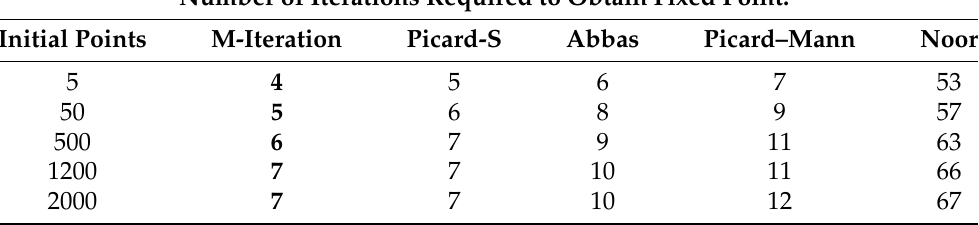
Figure 1. Convergence behaviors of different iterative schemes to a fixed point p 0 = 0 of the map J . Table 1. Initial points influence on different iteration algorithms. Number of Iterations Required to Obtain Fixed